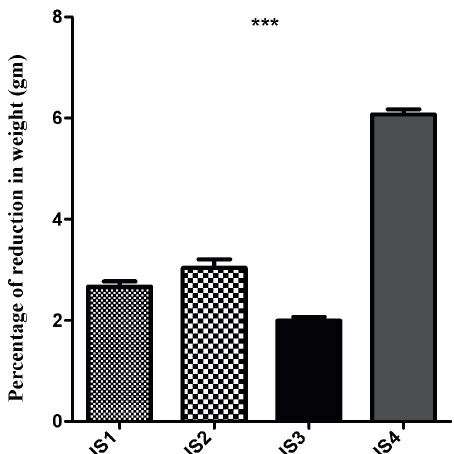
Figure 2. Observation of the amount of leather degraded by the isolates. Graphical representation showing the leather degrading activity of the isolates. Y-axis indicates the percentage of reduction in weight of the leather in gram (gm) and the X-axis denotes the test isolates. Data (n = 3) illustrated in the bar diagram as mean +SD. ***p < 0.0001 as determined by One-way ANOVA (IS1 to IS4 represents the